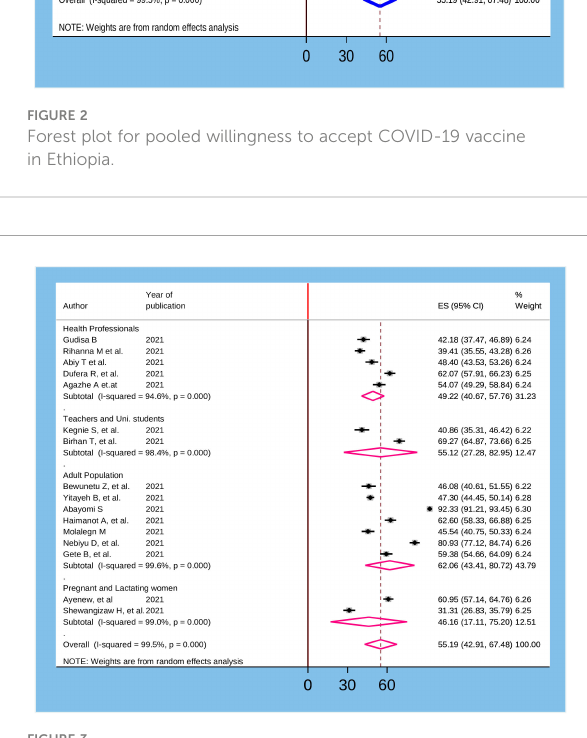
FIGURE 3 Sub group analysis based on the participants of the study for willingness to accept COVID-19 vaccine in Ethiopia, 2022.